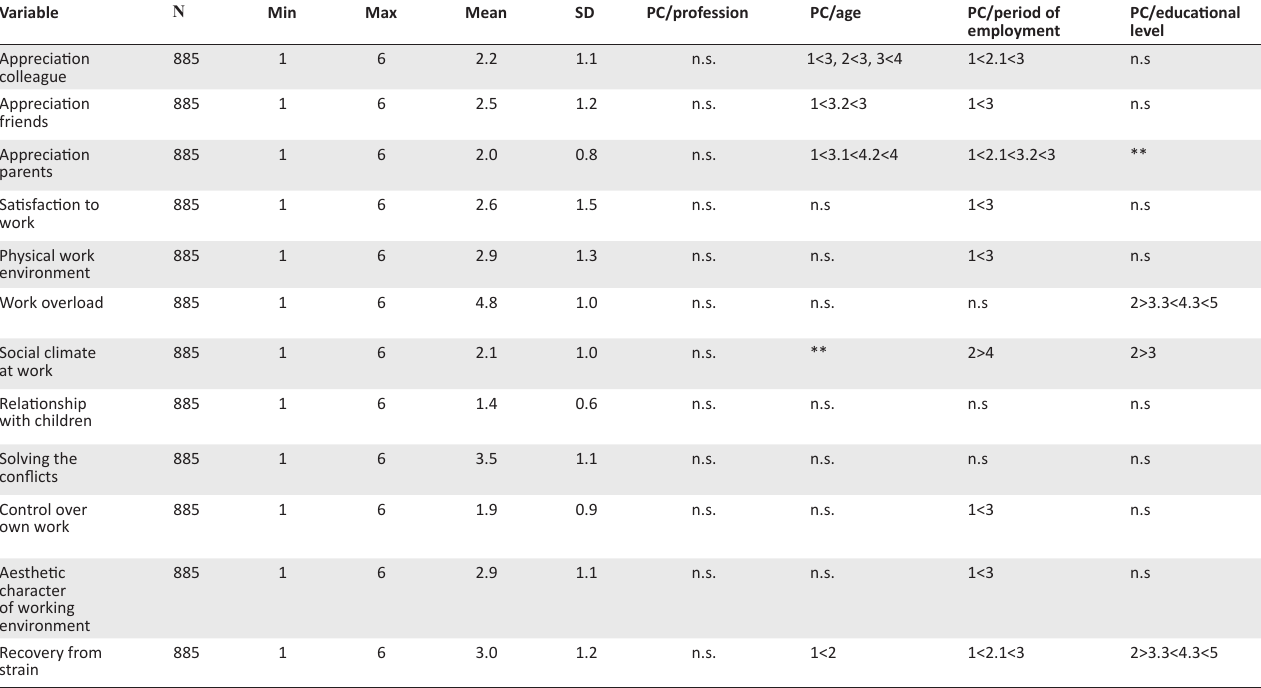
TABLE 2: ECPs’ experienced job satisfaction and appreciation and pairwise comparisons according to the background characteristics. Variable